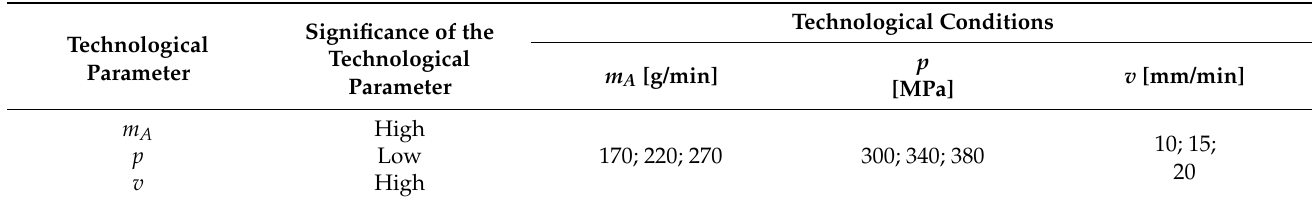
Table 7. Significance of technological parameters influencing the quality of the cut